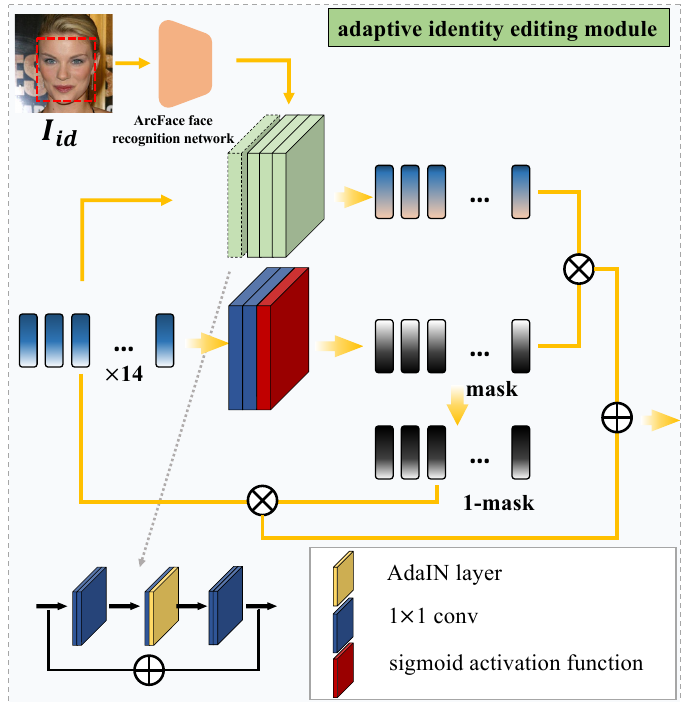
Figure 4. The structure of the adaptive identity editing